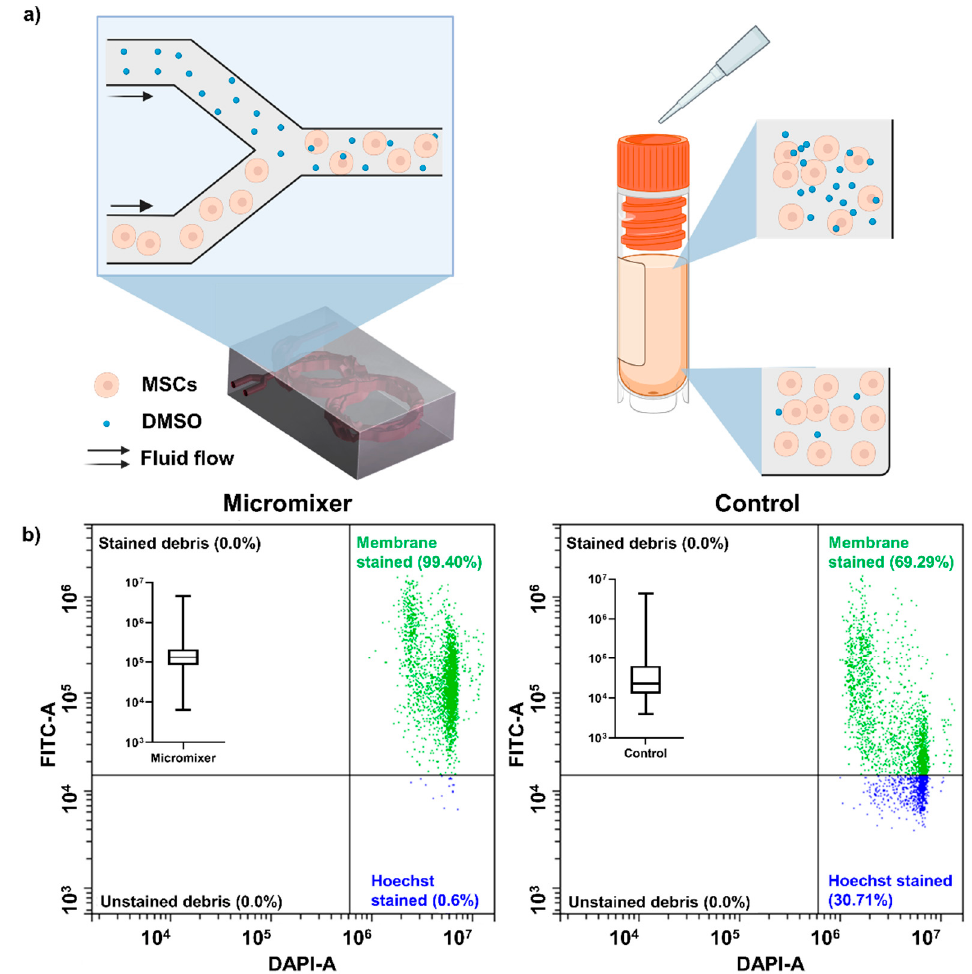
Figure 3. Cytoplasmic dye was added into DMSO to verify the homogeneous mixing of the micromixer experimentally. ( a ) Schematic illustration of the mixing strategies between micromixer and manual mixing. The micromixer introduced DMSO into cells at a constant ratio, while manual mixing faces challenges of uneven distribution of DMSO at the beginning. ( b ) The flow cytometry results of cells mixed with cytoplasmic dye–DMSO in two methods: micromixer (left) and manual mixing (right). The inserted box plots show the level of FITC staining of each cell were summarised in box plot. The results show that the cells in the micromixer groups were more evenly stained than the manual mixing group, and the difference of distribution was significant ( p < 0.001).